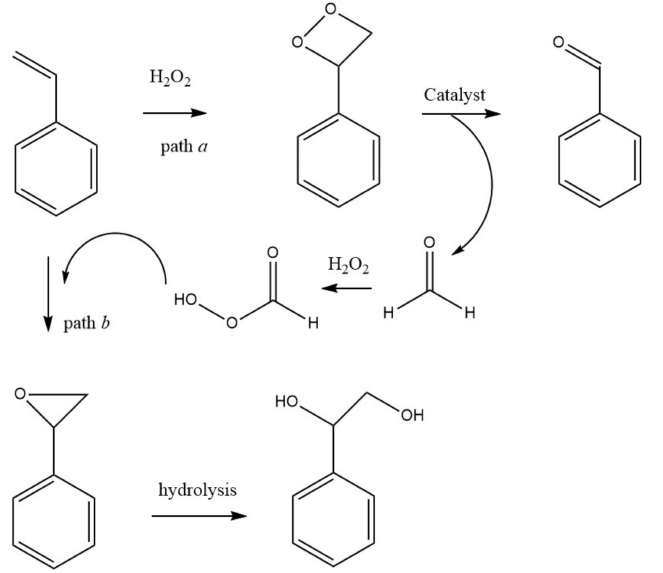
Figure 21. Proposed mechanism for the oxidation of styrene catalyzed by Co 3 O 4 @-HZSM-5 [144].